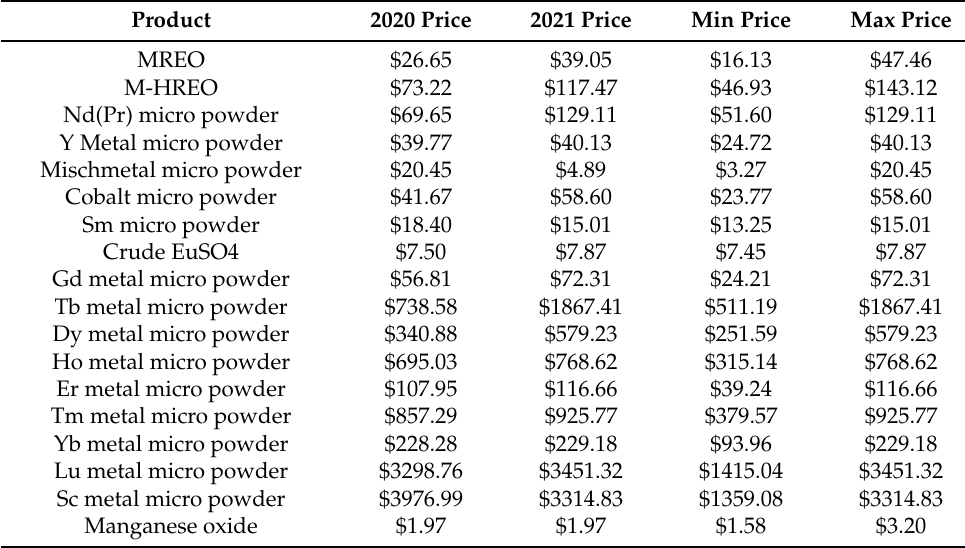
Table 3. Pricing Scenarios used for Analyses, all values in